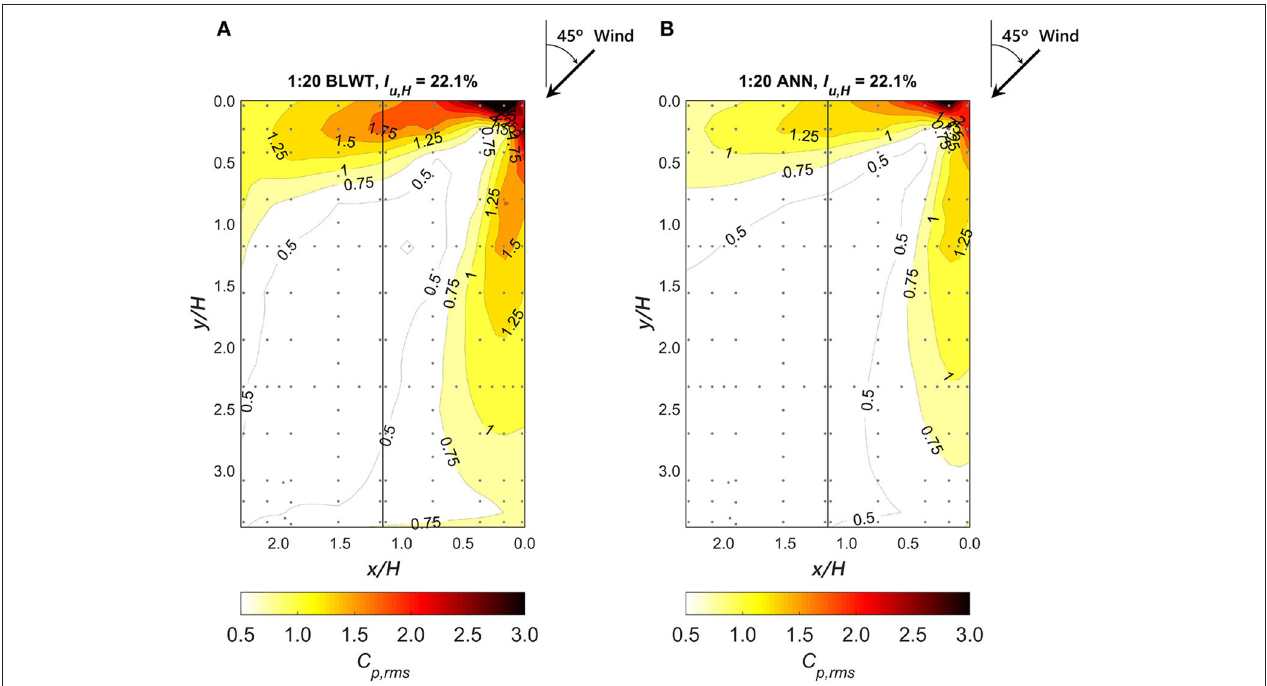
FIGURE 10 | Prediction of RMS pressure coefficients ( C p , rms ) for the 1:20 WERFL model and a freestream turbulence intensity of 22.1% at eave height: (A) BLWT experimental data and (B) ANN